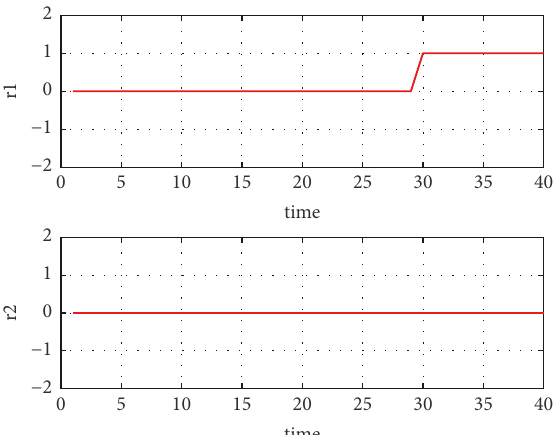
Figure 11: Normalized residue for step and decrease of the ampli- tude